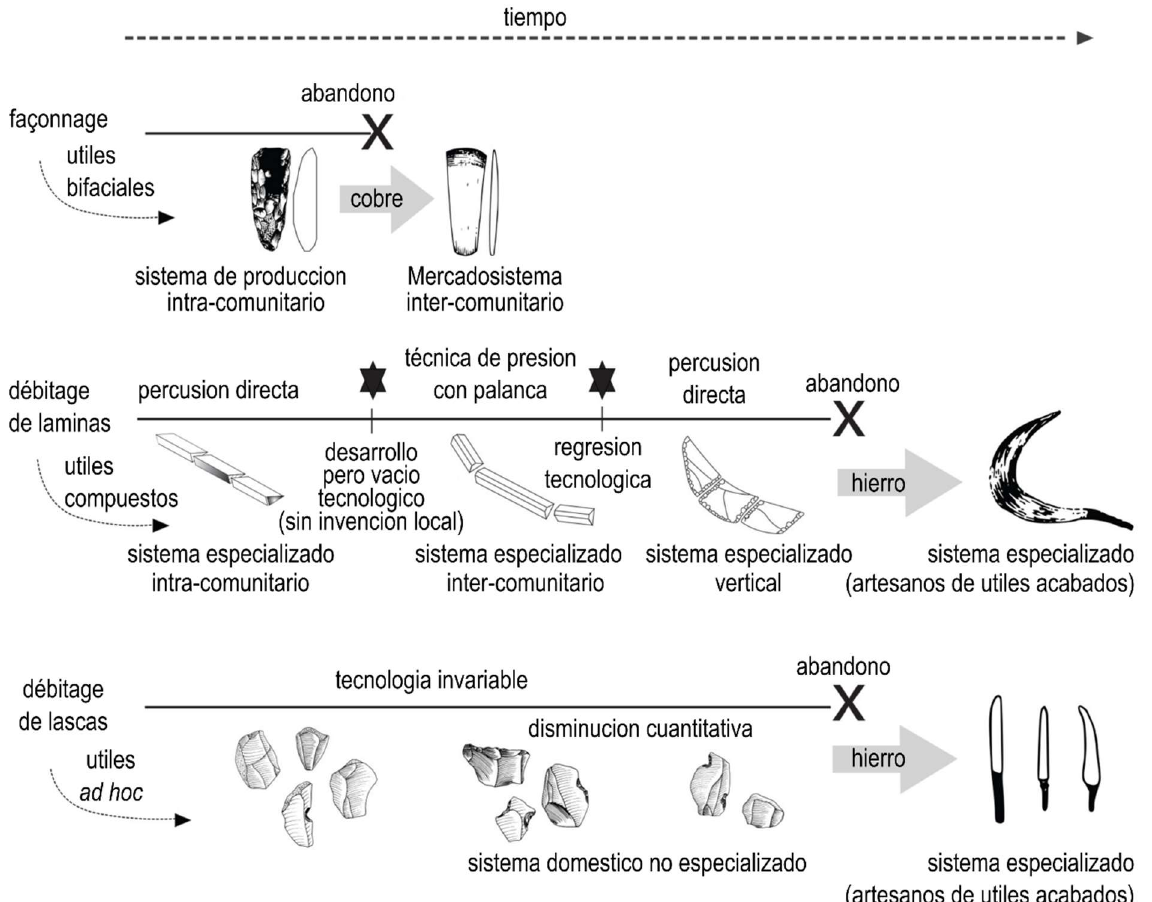
Figura 17. Tres linajes de producción diferentes ( façonnage , débitage laminar, débitage de lascas) que fueron reemplazados por linajes de objetos metálicos, siguiendo diferentes trayectorias y ritmos (Manclossi et al . 2019: fig.